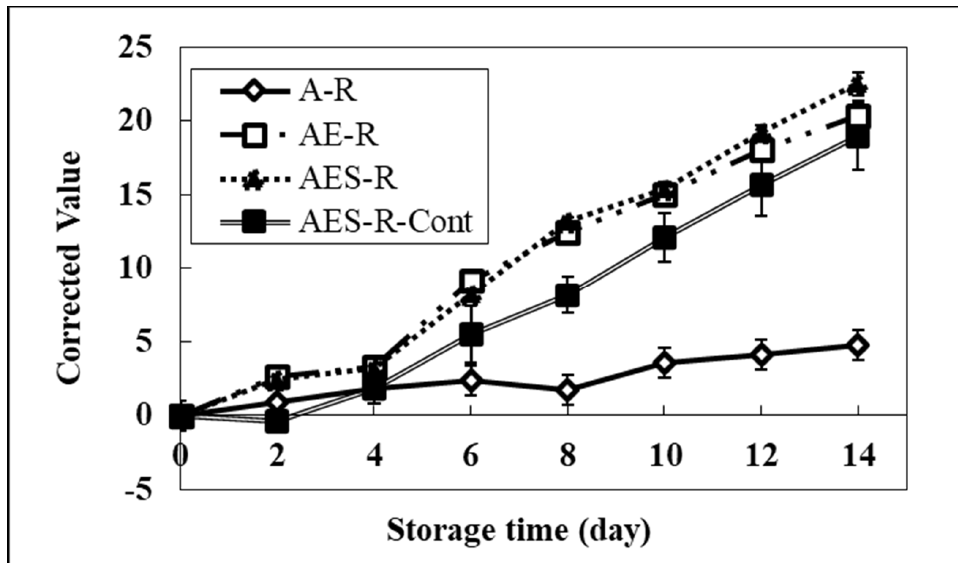
Figure 4. Brightness (“L”) of model systems containing resazurin for 14 days. Note that it was used for calibrating our system. A-, AE-, and AES- stand for agar, agar and emulsifier, and agar, emulsifier, and soybean oil, respectively. AES-R-Cont represents AES-R system covered with pure GBF. Bars indicate the standard deviation.